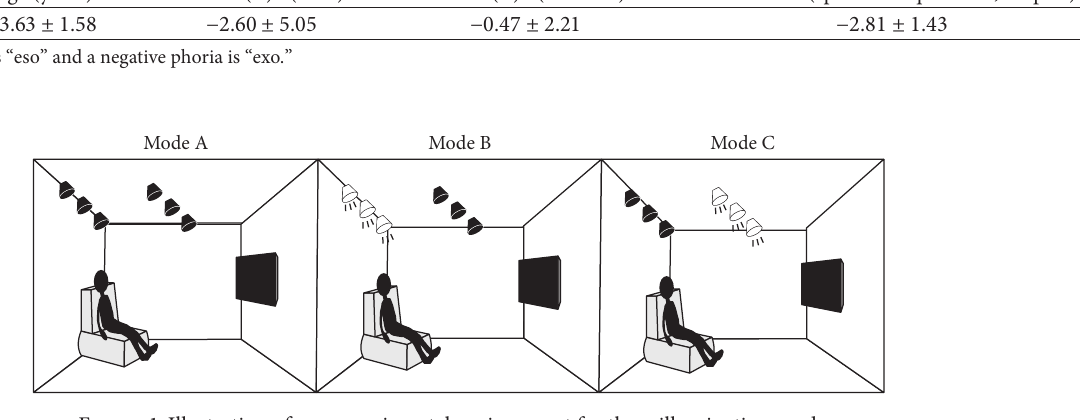
Figure 1: Illustration of our experimental environment for three illumination